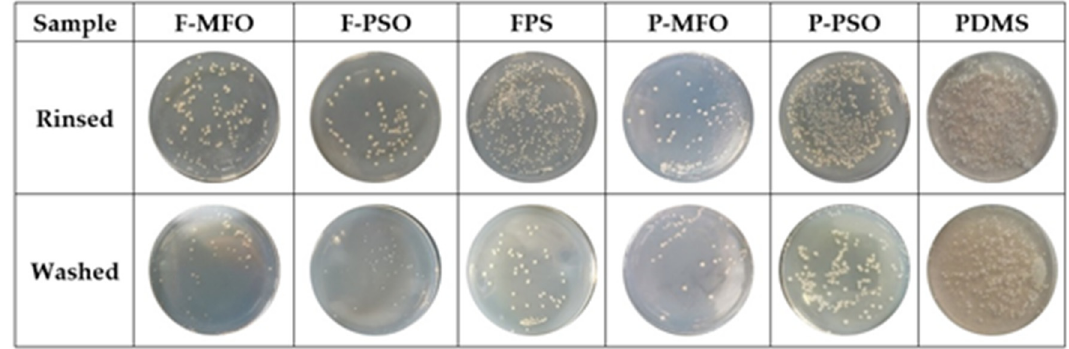
Figure 9. Original images of marine bacterial colonies.